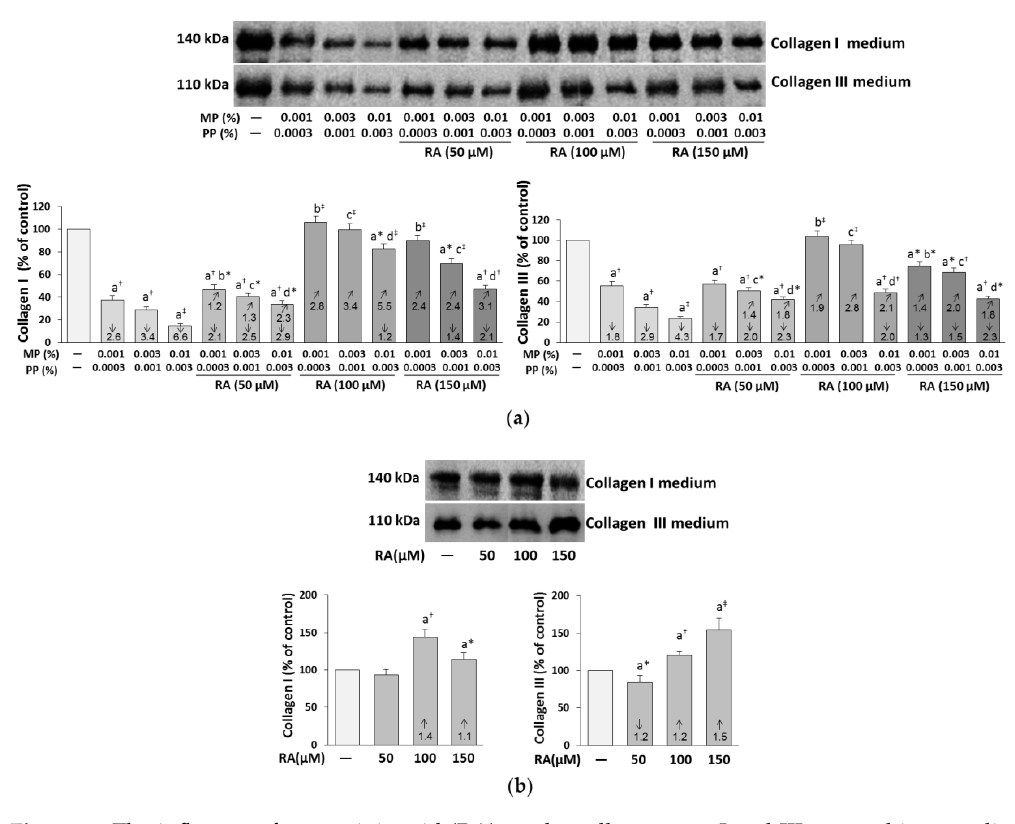
Figure 4. The influence of rosmarinic acid (RA) on the collagen type I and III secreted into media by the fibroblasts treated with methylparaben (MP) and n-propylparaben (PP) ( a ), and untreated cells ( b ). Representative gels of Western blotting, the intensity of the collagen bands was quantified by densitometry, values represent the mean (% of control) ± SD of three experiments. Statistically significant differences are marked as: a vs. control, b vs. 0.001% MP and 0.0003% PP, c vs. 0.003% MP and 0.001% PP, d vs. 0.01% MP and 0.003% PP; * p < 0.05; † p < 0.01; ‡ p < 0.001. The values in the bars show a factor of change in comparison to the control ( ↑ , increase; ↓ , decrease) or to the respective samples treated with parabens alone (MP and PP) ( ↗ , increase).